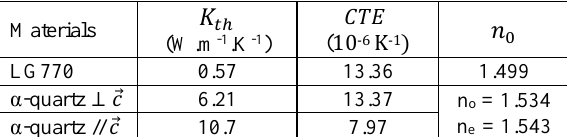
Table 1. Key parameters of both LG-770 (supplied by Schott) and α-quartz (supplied by Sawyer Technical materials).